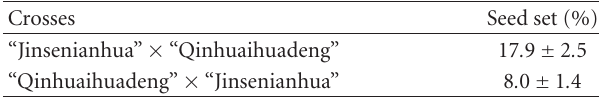
Table 3: Seed set of the two lotus crosses. Crosses Seed set